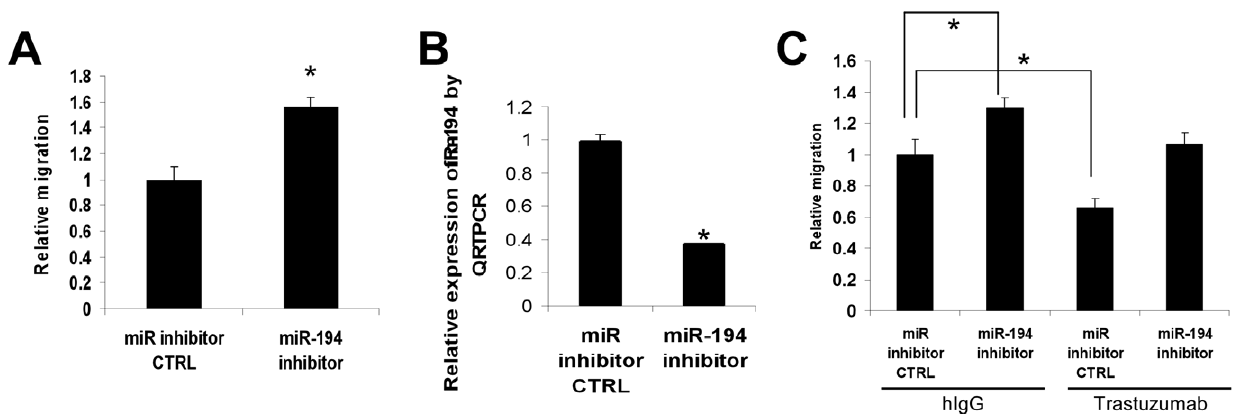
Figure 5. miR-194 inhibitor stimulates cell migration and blocks trastuzumab-inhibited cell migration. ( A ) Effect of miR-194 inhibitor on cell migration in SKBr3 cells. SKBr3 cells were transiently transfected with a miR-194 inhibitor or its negative control (miR inhibitor CTRL) for 48 hrs before measurement of migration overnight. * p , 0.05 compared to the negative control. ( B ) Validation of efficacy of miR-194 inhibition. SKBr3 cells were transiently transfected with a miR-194 inhibitor or its negative control (miR inhibitor CTRL) for 48 hrs. Total RNA was prepared and miR-194 measured by QRT-PCR. * p , 0.05 compared to miR inhibitor control. ( C ) Effect of miR-194 inhibitor on trastuzumab-inhibited cell migration. SKBr3 cells were transiently transfected with a miR-194 inhibitor or its negative control (miR inhibitor CTRL) for 16 hrs, treated with trastuzumab (Tras) or control hIgG (10 m g/ml) for 36 hrs, and motility was then measured for overnight in Transwell assays. * p , 0.05.